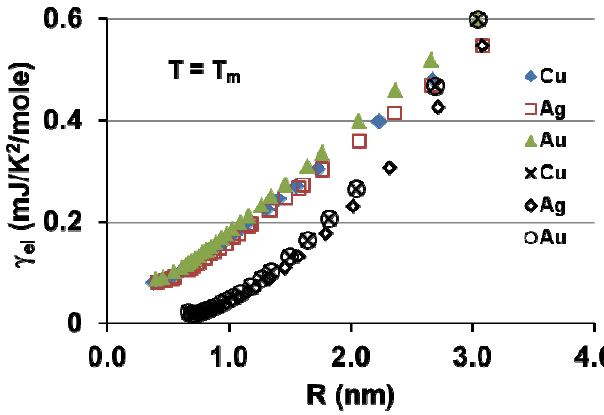
(colored points) and for T < T m